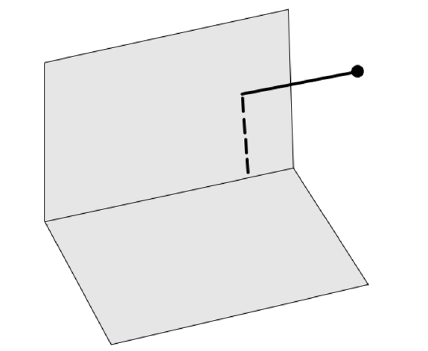
Figure 2 . Diagrammatic representation of the wall channel expansion. The thick line represents the bulk to boundary expansion and the dashed line represents the one point function on the